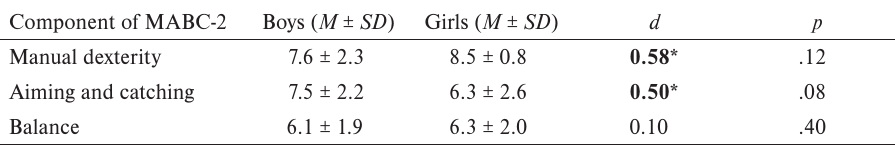
Gender differences in standards score in each component of MABC-2 in children with rDCD Component of